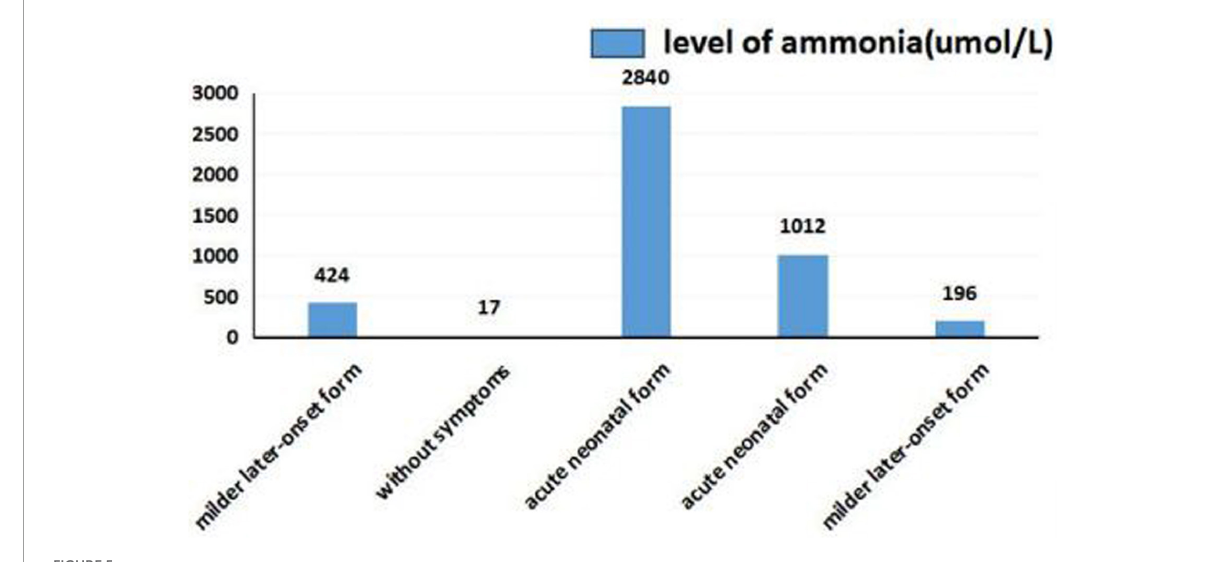
FIGURE5 Ammonia levels in different clinical phenotypes.